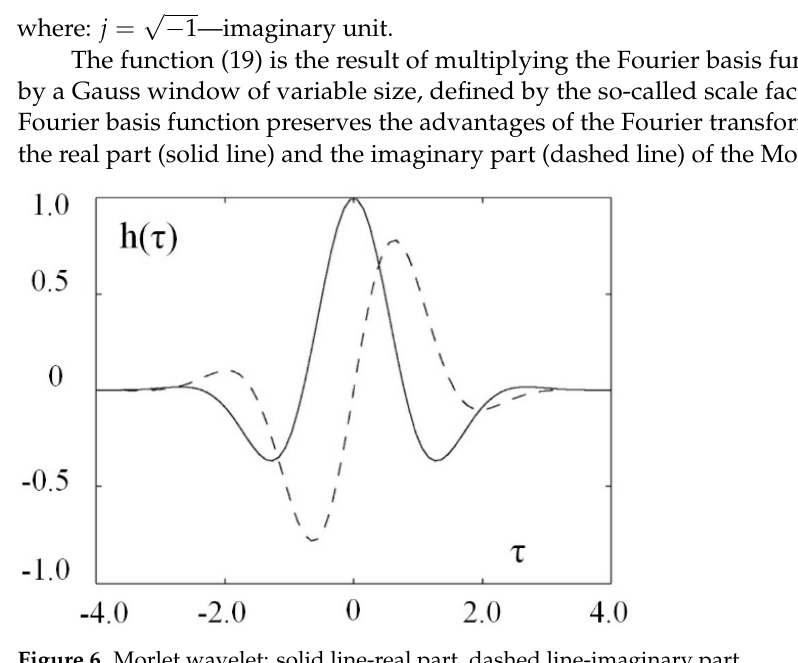
Figure 6. Morlet wavelet: solid line-real part, dashed line-imaginary part.